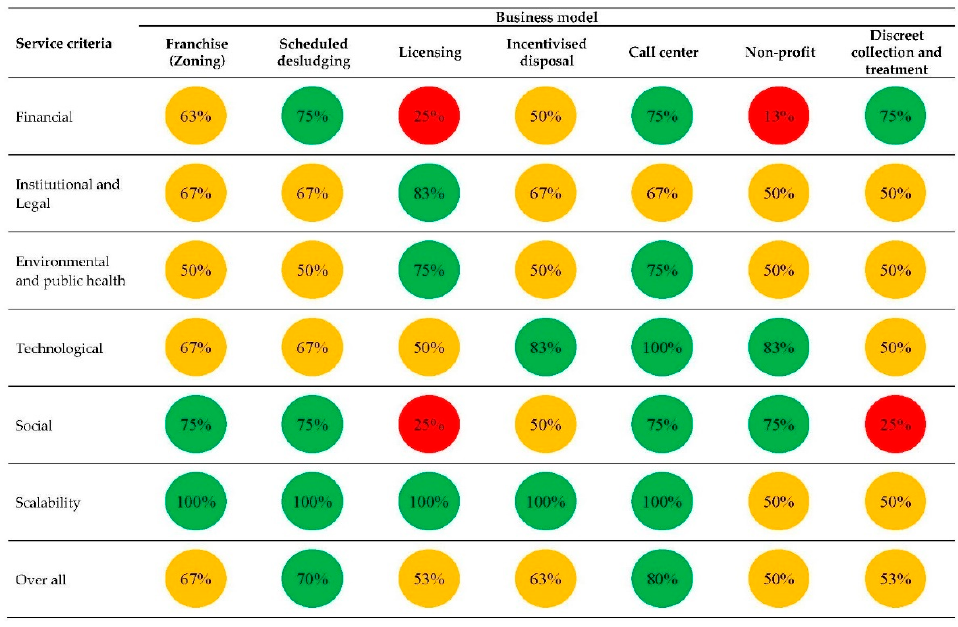
Figure 2. Business model scorecard for cesspool (Supplementary material